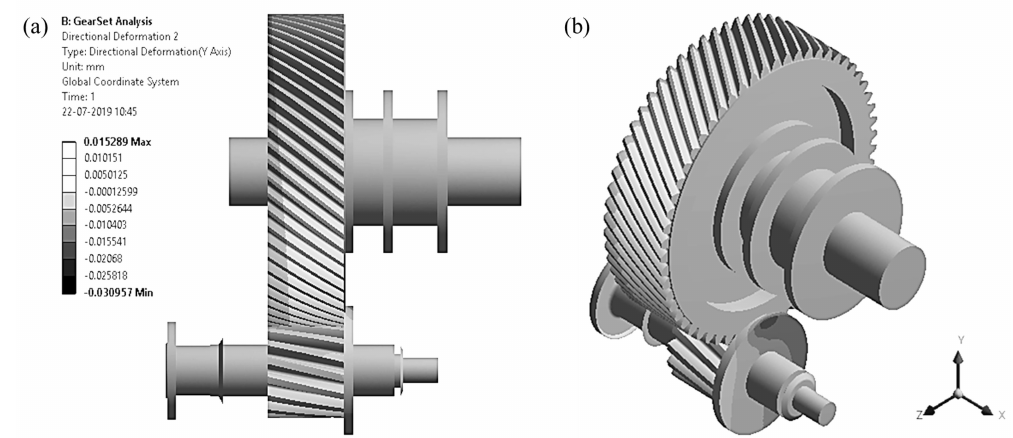
Figure 7. ( a ) Deformation computed in gearset in y-direction; ( b ) isometric view of gearset with deformation